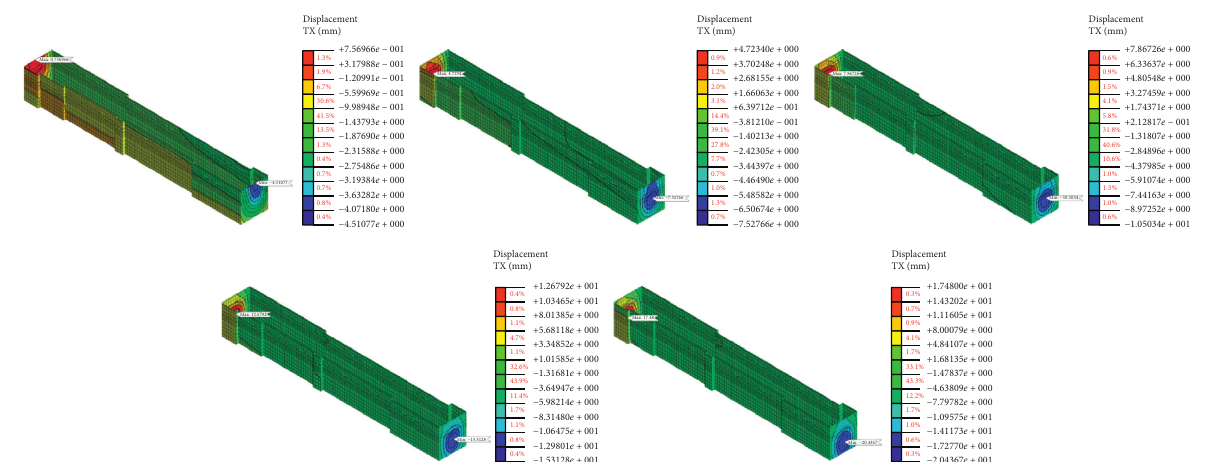
Figure 4: The horizontal displacement of the short side of the underground diaphragm wall in the X -direction under each analysis